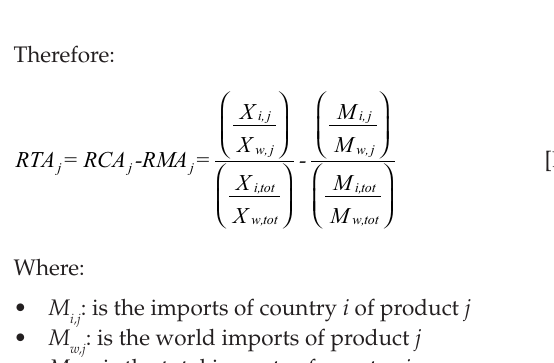
Therefore: TABLE 1: Categorisation of product-country combinations in Step 1.1.